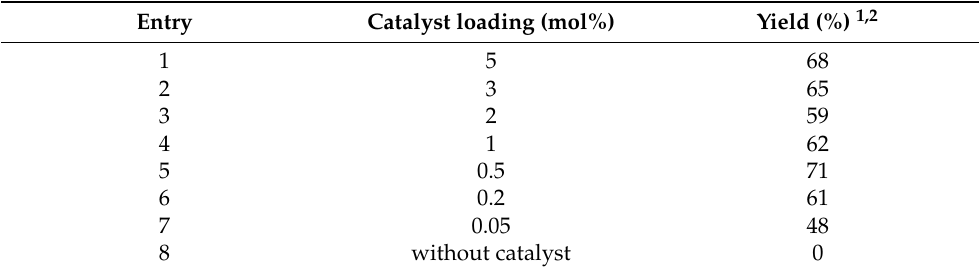
Table 5. Screening of Pd(PPh 3 ) 4 loading for Suzuki coupling of 1 with 2